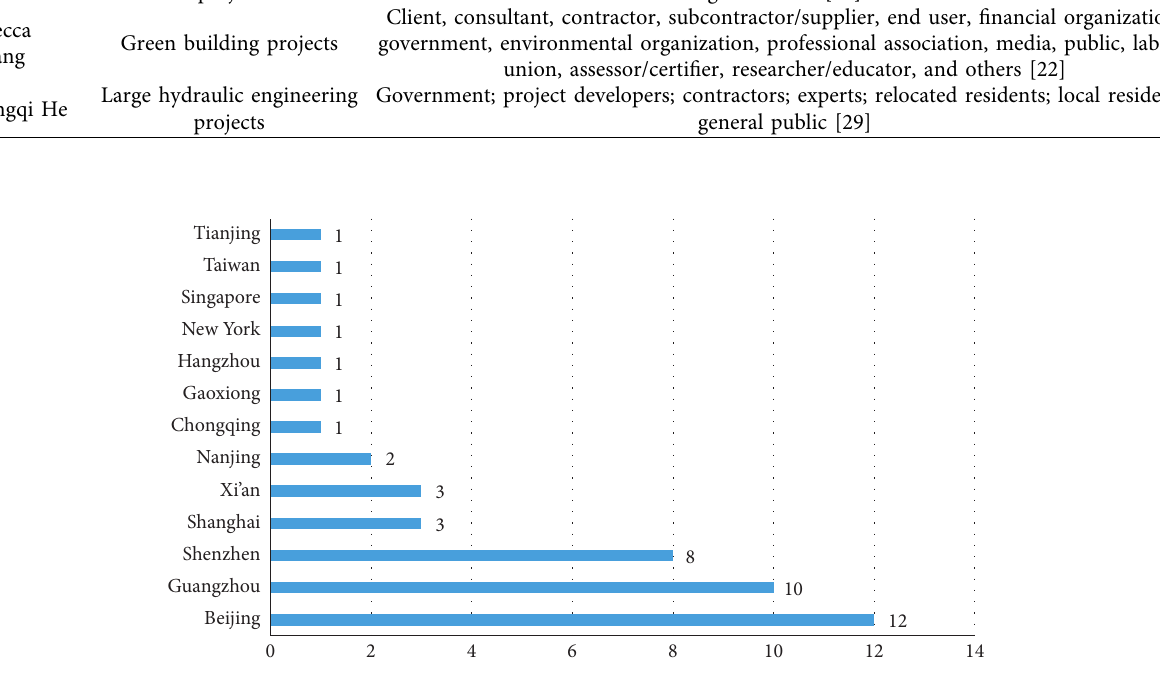
Figure 2: The number of cases in different regions.